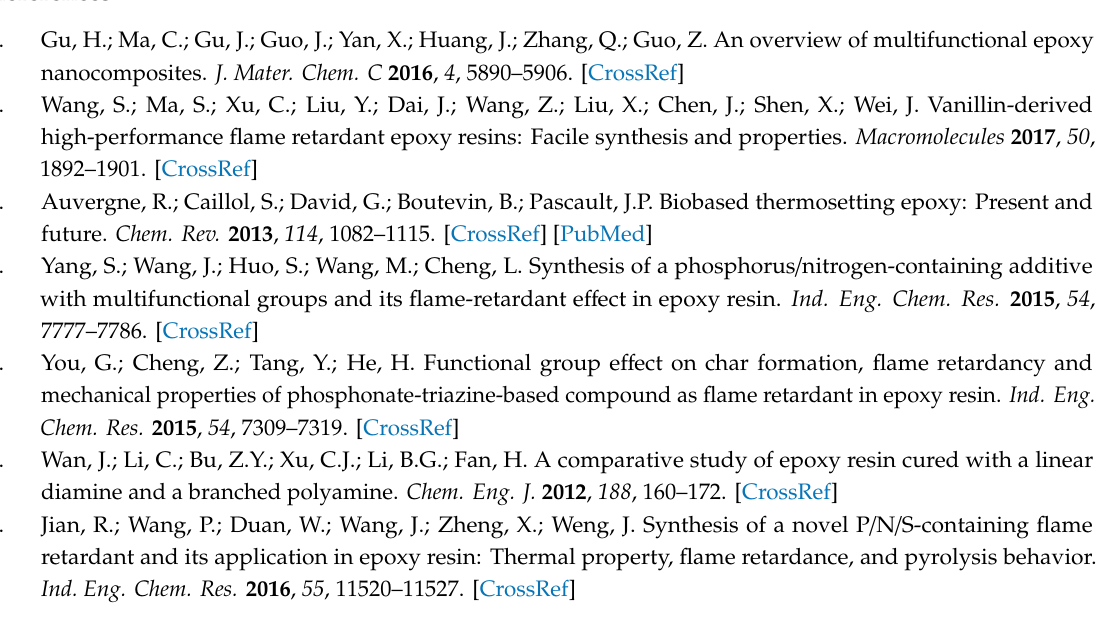
Figure S1: The 1H NMR spectrum (a) and 31P NMR spectrum (b) of HPP with DMSO-d6 as the solvent, Figure S2: SEM observations of submicro-scaled AHPP: low-magnification (a) and magnified image (b), Figure S3: TEM image (a) and EDX spectrum (b) of submicro-scaled AHPP, Figure S4: SEM micrographs of the char residue of pristine EP (a,b), EP / DOPO-AHPP (c,d), and EP-AHPP (e,f), and elemental distribution from EDX mapping of the EP-AHPP composite (g–i), Table S1: Assignments of the peaks in FTIR spectra of cured epoxy resin and its